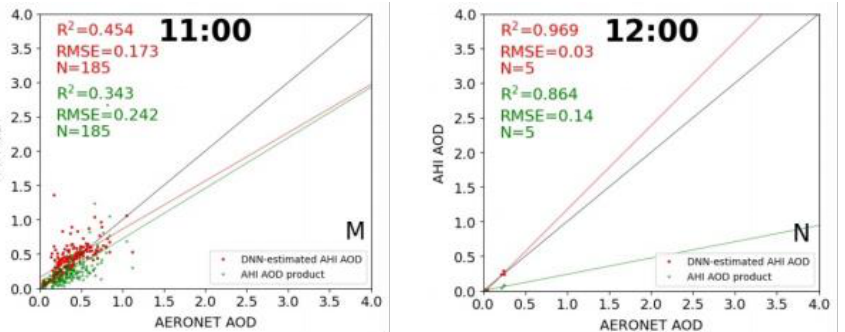
Figure 7. Hourly comparisons between the AHI AOD and AERONET AOD (red dot: DNN-estimated AHI AOD; green dot: AOD extracted from AHI product; panels ( A – N ): 22:00~23:00 and 1:00~12:00 (UTC)).